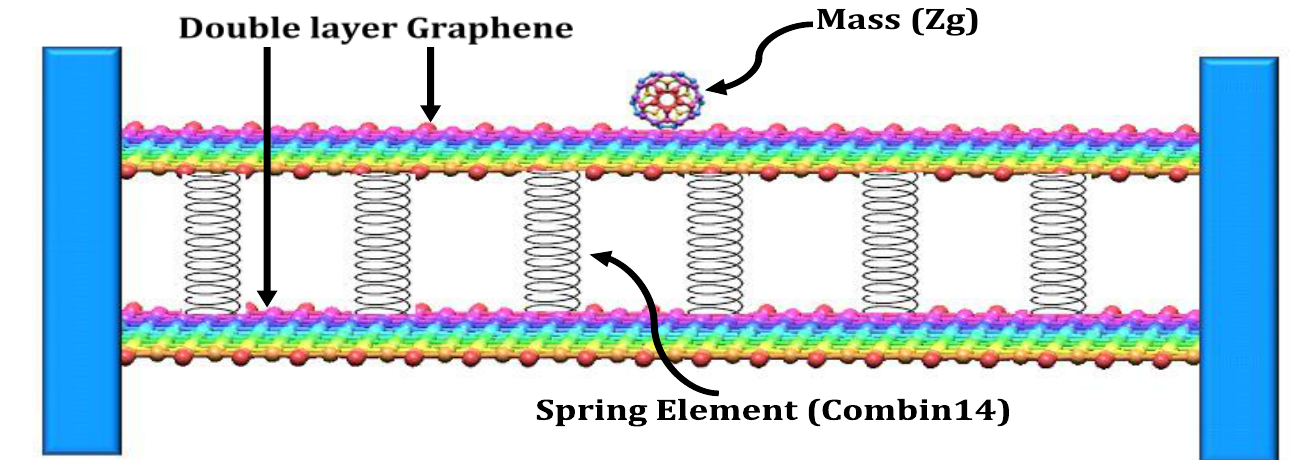
Figure 1. Double-layer graphene with spring element (Combin 14) and zeptogram mass attached in centre of sheet.